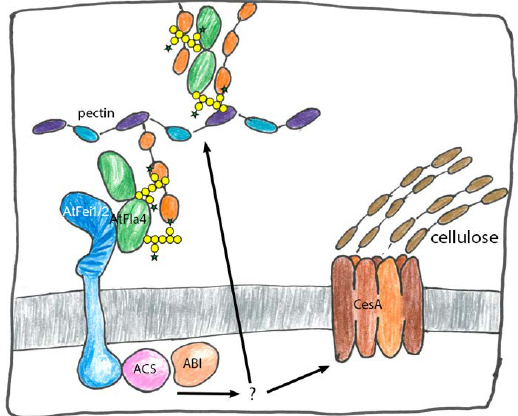
Figure 5. Hypothetical roles of AtFla4 in cell wall structure and signaling. AtFla4 might interact with the pectic network with covalent or non-covalent interactions of its glycans (yellow discs and green stars: O- glycans which are yet to be precisely defined, N- glycans are omitted). It might mechanically link pectin with AtFei1 and AtFei2 receptor kinases and the plasma membrane. The signals transduced by the receptor kinases might involve ACC synthase (ACS) and Abcisic Acid Insensitive 1 (ABI1). How signaling connects the kinases with cellulose synthase (CesA) and pectin biosyn thesis is